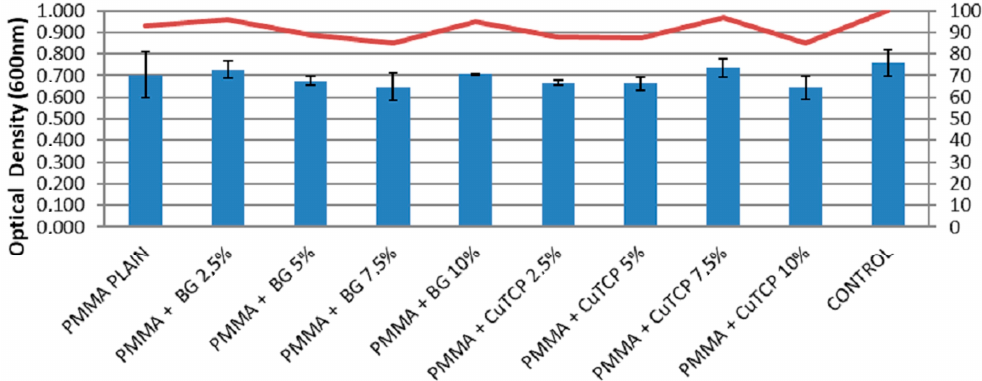
Figure 3. MTT assay. Optical density mean values at 600 nm and standard deviation of BMMSCs grown on the different modified PMMA based bone cement.